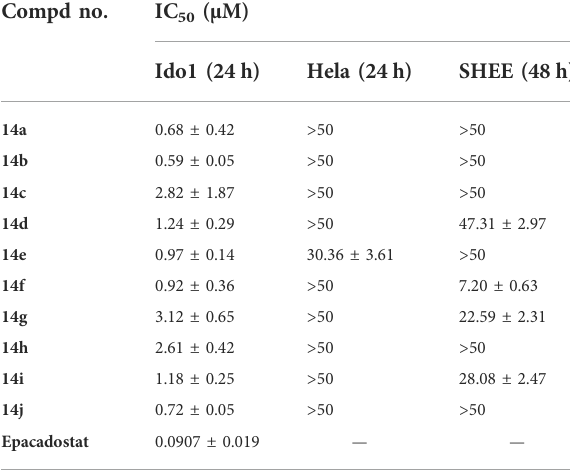
IC 50 valueswere fi ttedfromsinglepointinhibitioncurves,andtwoparallelexperiments wereperformedforeachcompound.IC 50 valueswerecalculatedusingGraphPadPrism 8.0 software. These results are reported as the averages